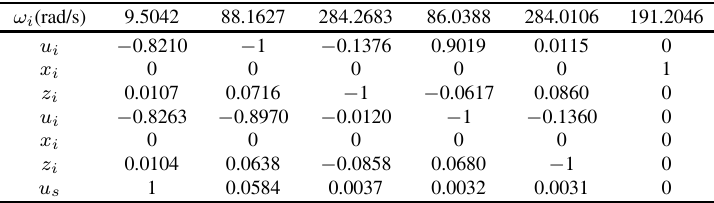
Table 3(b) Modes of the drive system with eccentric center worm